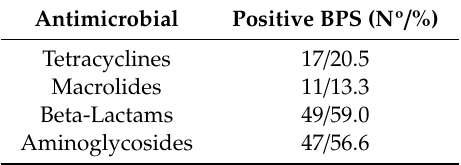
Figure 1. Geographical distribution of positive samples to antimicrobial belonging to families of Tetracyclines, Macrolides, Beta-Lactams and Aminoglycosides. Table 2. Positivity of backyard productive systems (BPS) to antimicrobials residues in central Chile,